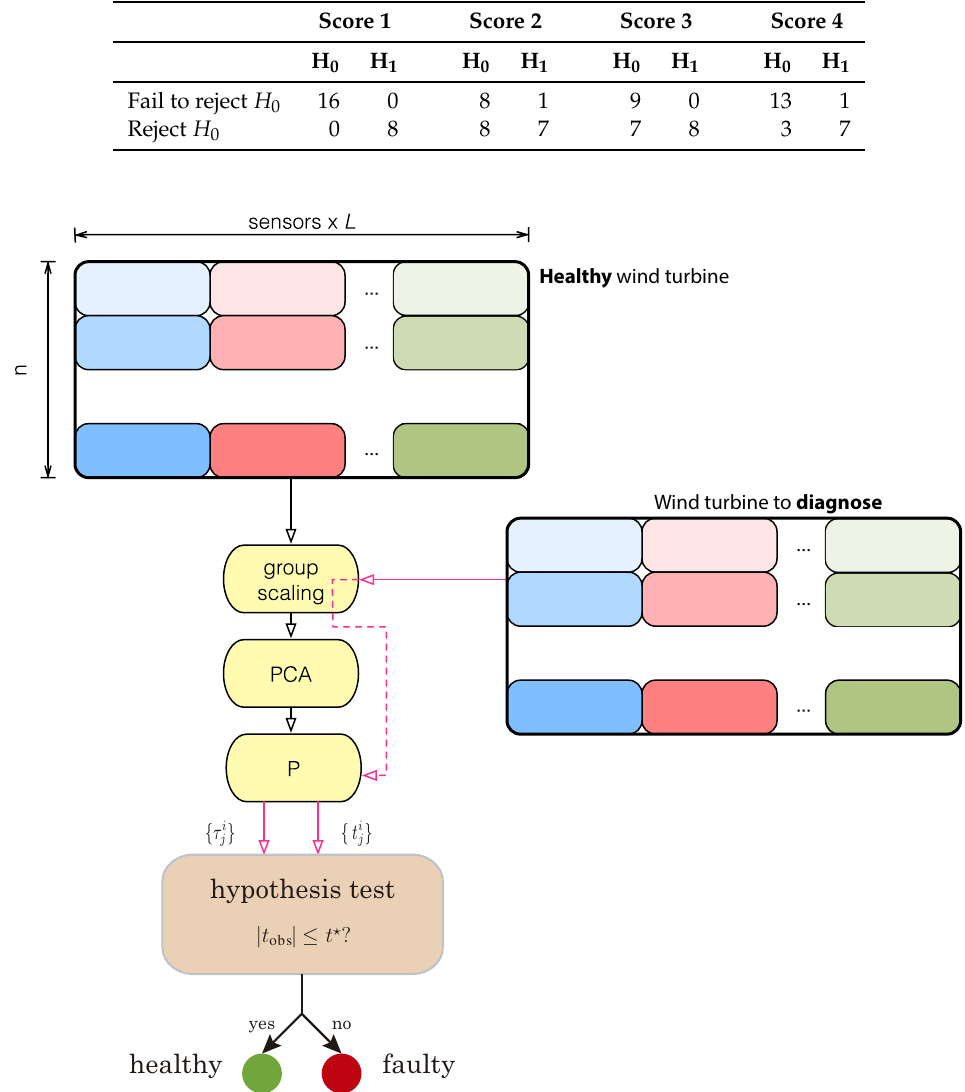
Figure 1. The fault detection strategy is based on testing for notable changes in the distributions of the sample coming from the healthy wind turbine and the sample coming from the current wind turbine to diagnose